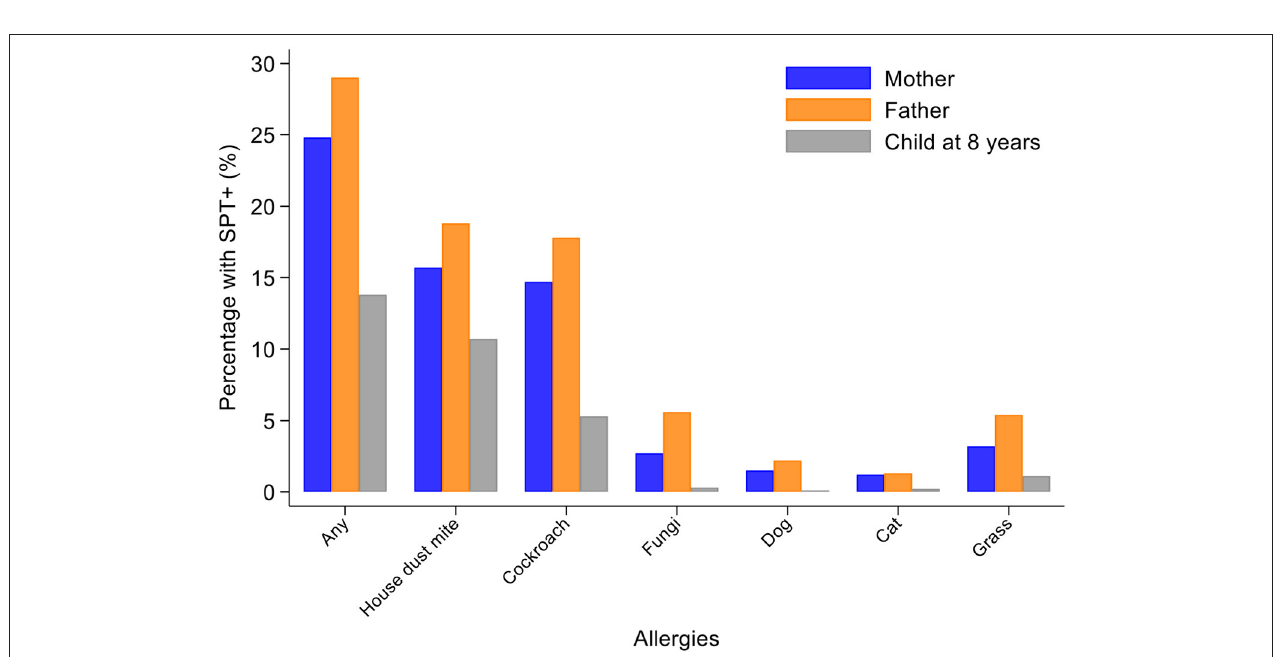
FIGURE 2 | Percentages of mothers, fathers, and cohort children (at 8 years) with positive skin prick tests (SPT + ) to any allergen and individual allergen extracts. Data for Mothers ( n = 2,031) (blue bars), fathers ( n = 1,191) (orange bars), and children at 8 years ( n = 1,952) (gray bars).